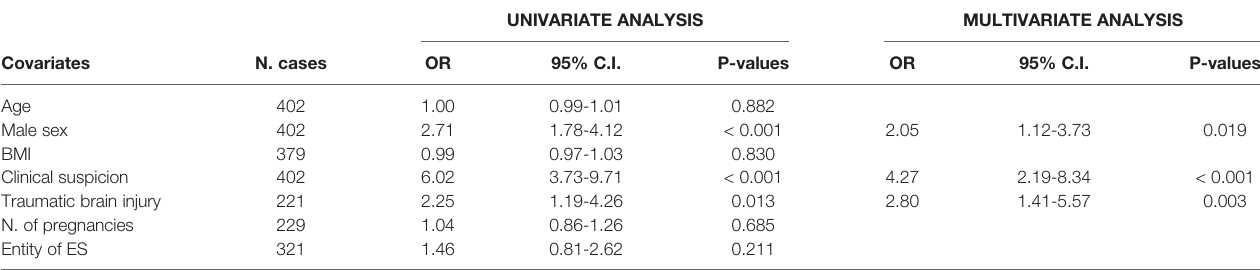
TABLE 3 | Results of univariate and multivariate logistic regression analysis assessing the determinants of pituitary hormone de fi ciency at study entry in subjects with empty sella. UNIVARIATE ANALYSIS MULTIVARIATE ANALYSIS Covariates N. cases